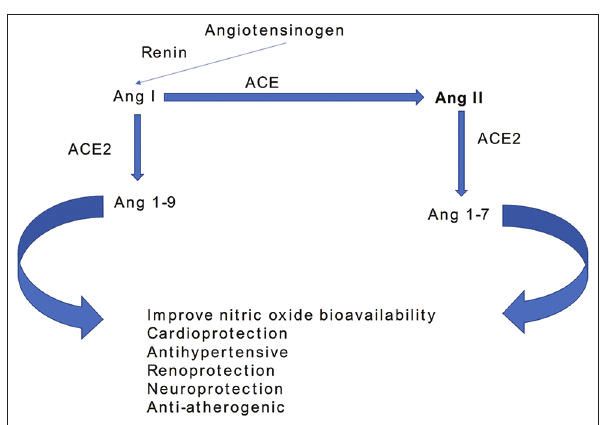
Figure-2: Catabolism of angiotensinogen and the catabolic products of novel angiotensin-converting enzyme